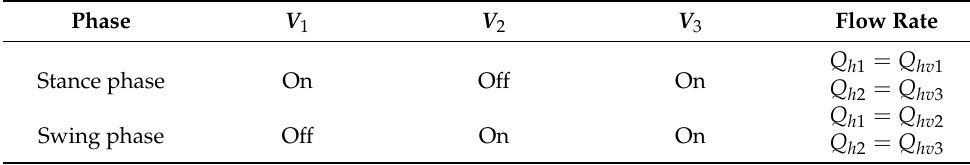
Table 2. Valve configuration in different